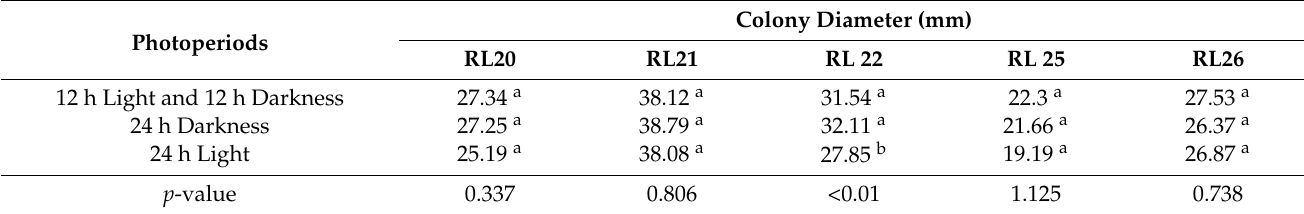
Table 7. Average colony diameters of all five isolates of R. microporus after 3 days of incubation under different photoperiods.